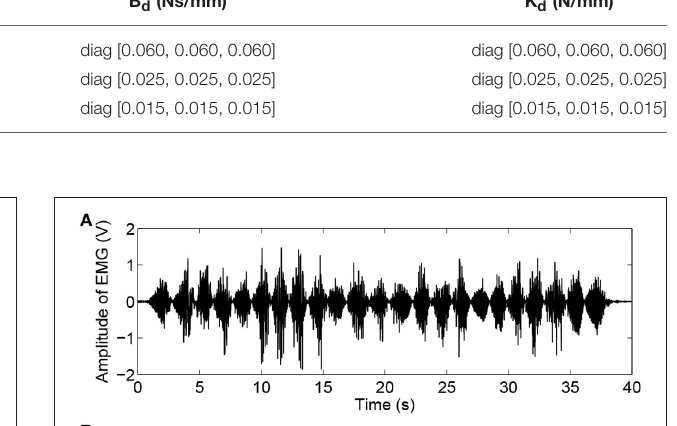
TABLE 1 | Admittance parameters of different working conditions. Conditions